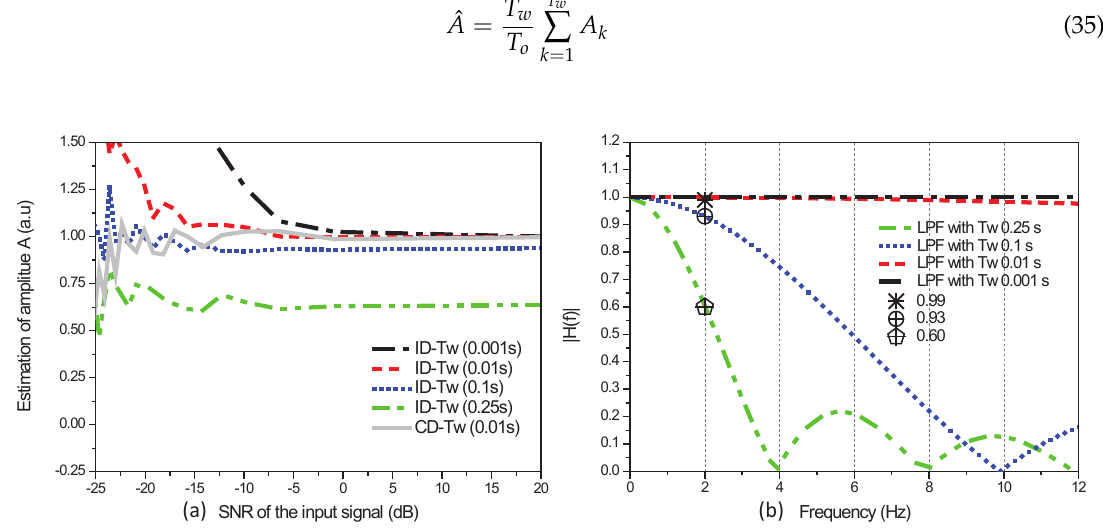
Figure 4. ( a ) Estimates of the input signal amplitude A as a function of the signal-to-noise ratio (SNR). Assessment of coherent detection (CD) and incoherent detection (ID) methods for different T w : 0.001 s, 0.01 s, 0.1 s and 0.25 s; ( b ) Frequency response of the Low-Pass Filters (LPF) with T w of 0.001 s, 0.01 s, 0.1 s and 0.25